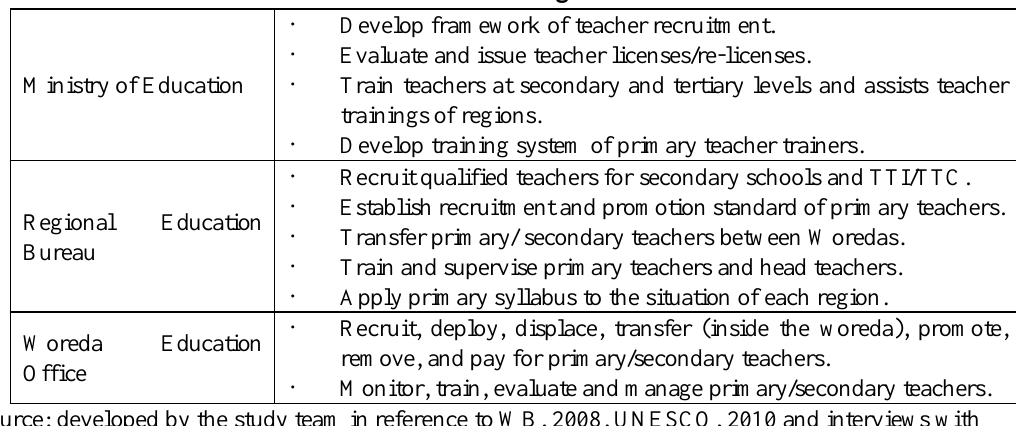
Table 4-16: Responsibilities of the Federal Government, Region and Woreda related to Teacher